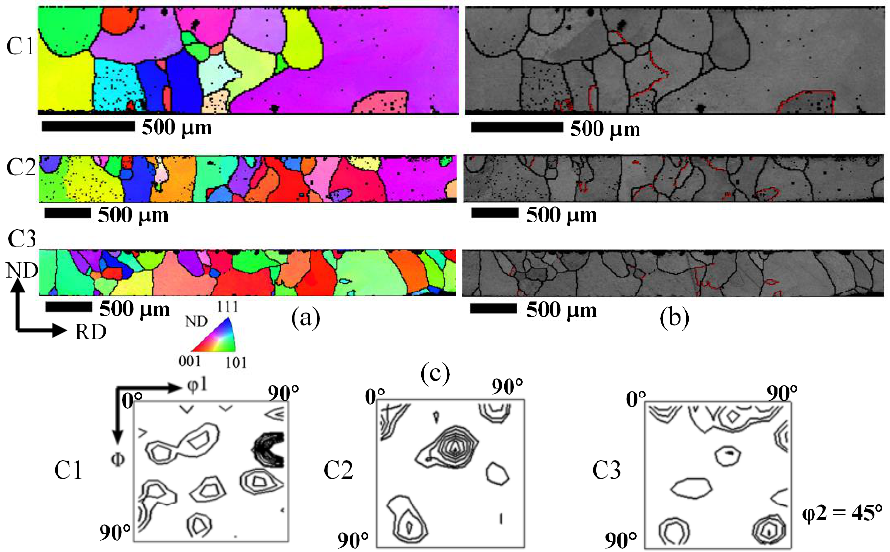
Figure 7. EBSD maps after final transformation treatment under 3 different processing parameters C1 to C3 of 1# sample, 0.5 mm thickness. ( a ) EBSD maps of IPF-ND, ( b ) Band contrast maps (red line: Σ3); ( c ) ODFs at ϕ 2 = 45° section.